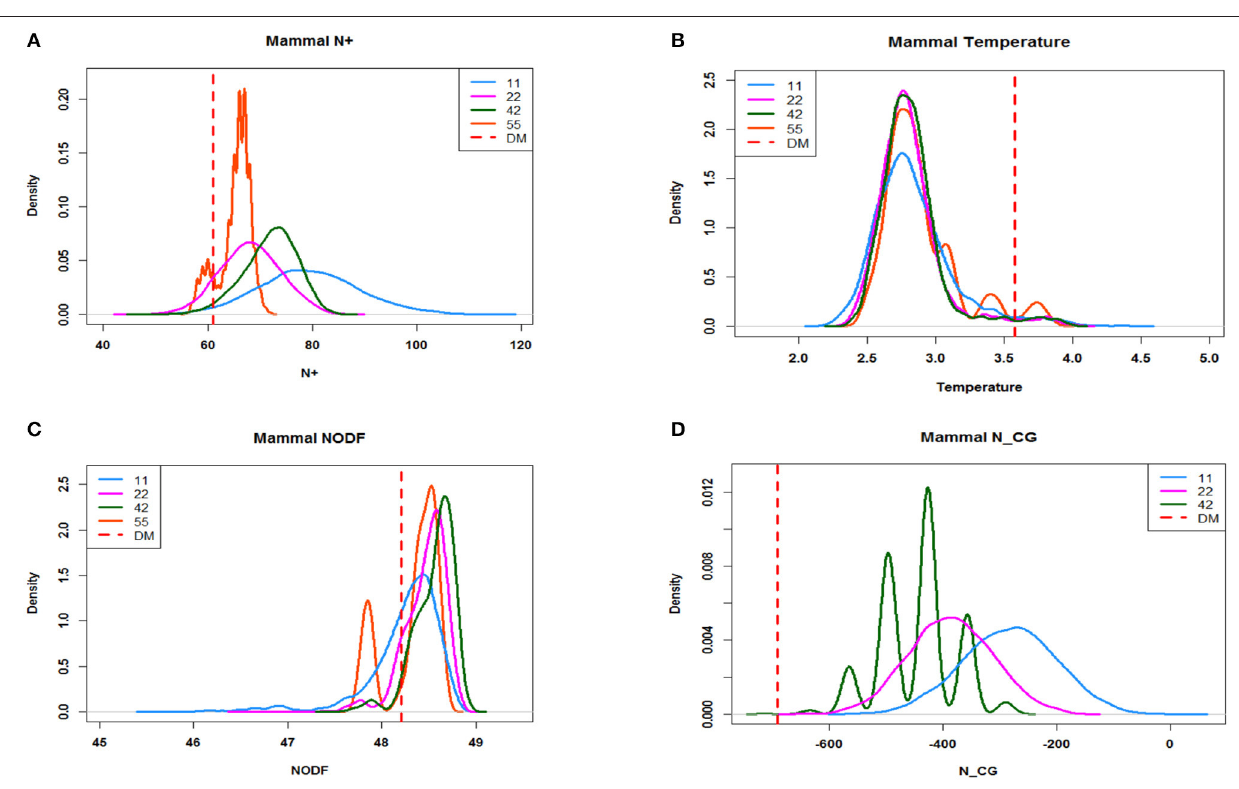
FIGURE 5 | The distribution of different indexes that are sampled, constrained by different scales of block structures. Each index and each scale of block structure are sampled 5,000 times using Miller’s algorithm. The dash line represents the indexes of Data Mechanics. (A) Distribution generated by N + . (B) Distribution generated by Temperature. (C) Distribution generated by NODF. (D) Distribution generated by N CG